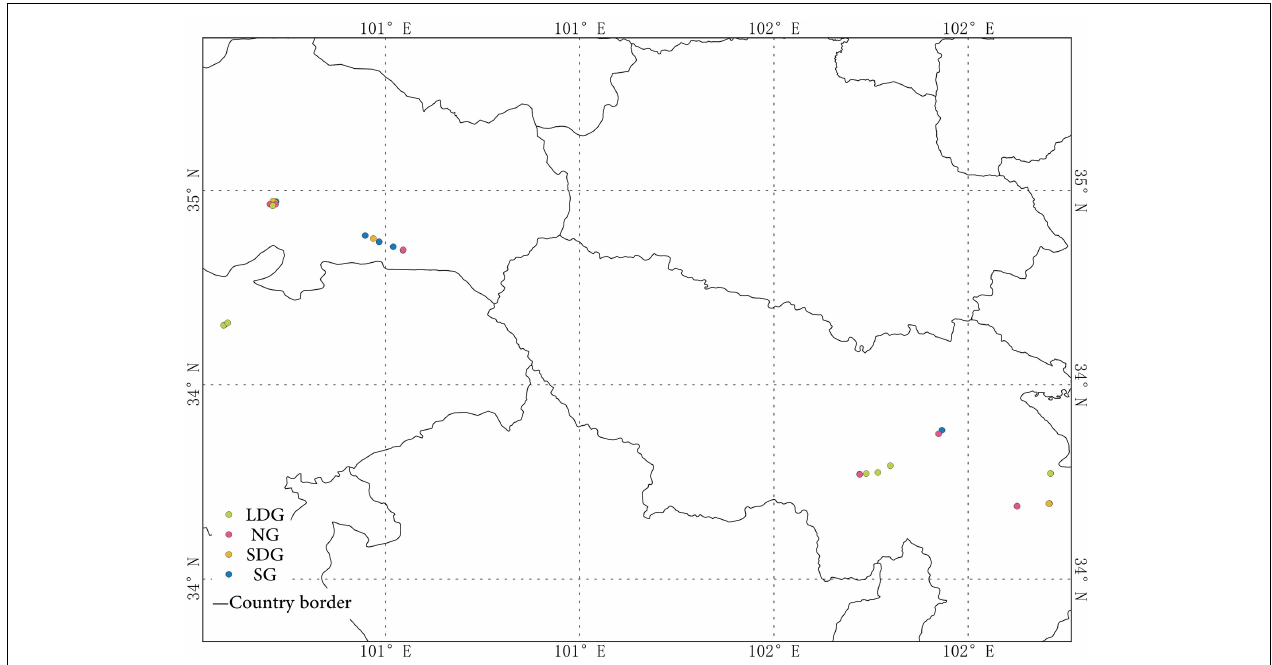
FIGURE 1 | Distribution of the sample sites. NG (red), natural grassland; SG (blue), sown grassland; LDG (green), lightly degraded grassland; SDG (yellow), severely degraded grassland.